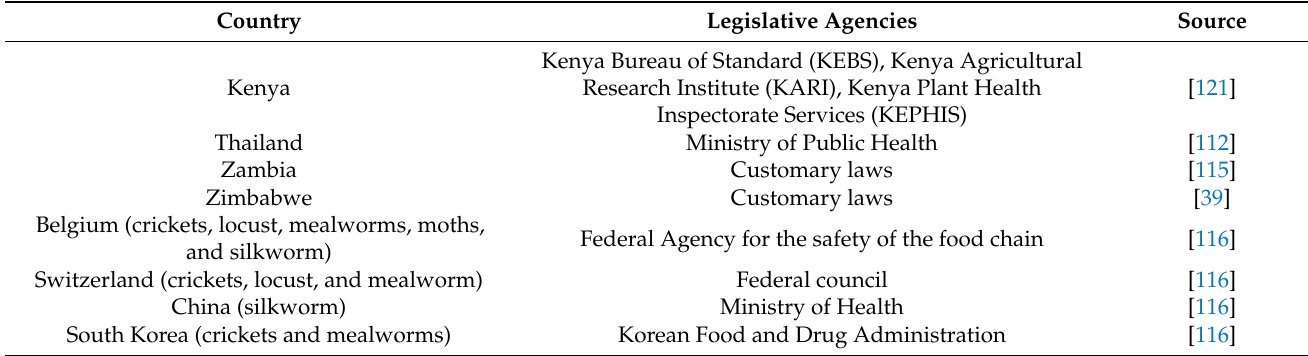
Table 2. Common legislative bodies governing insects’ production and consumption in different countries.